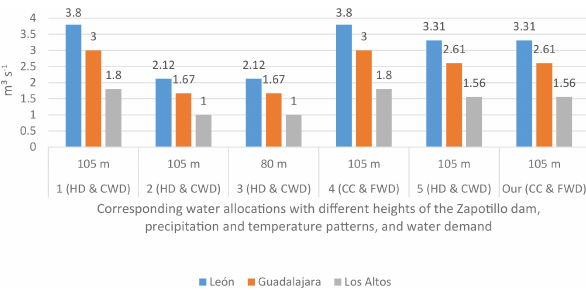
Figure 2. Key variables of the five water allocation scenarios (in m 3 s − 1 for León, Guadalajara, and Los Altos) developed by UN- OPS (2017b) and our scenario. “HD & CWD” is the historical runoff data and current water demand; “CC & FWD” is the runoff under climate change and future water